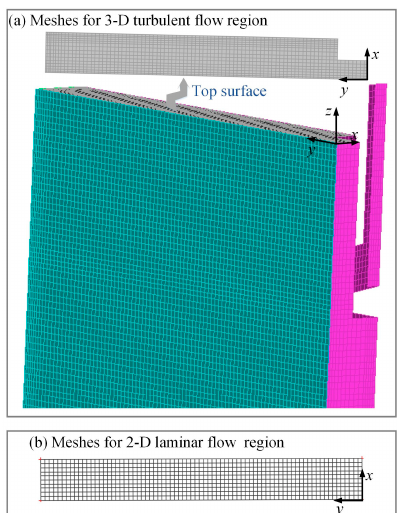
Figure 2. Meshes adopted in the ( a ) 3-D turbulent flow region and ( b ) 2-D laminar flow region.